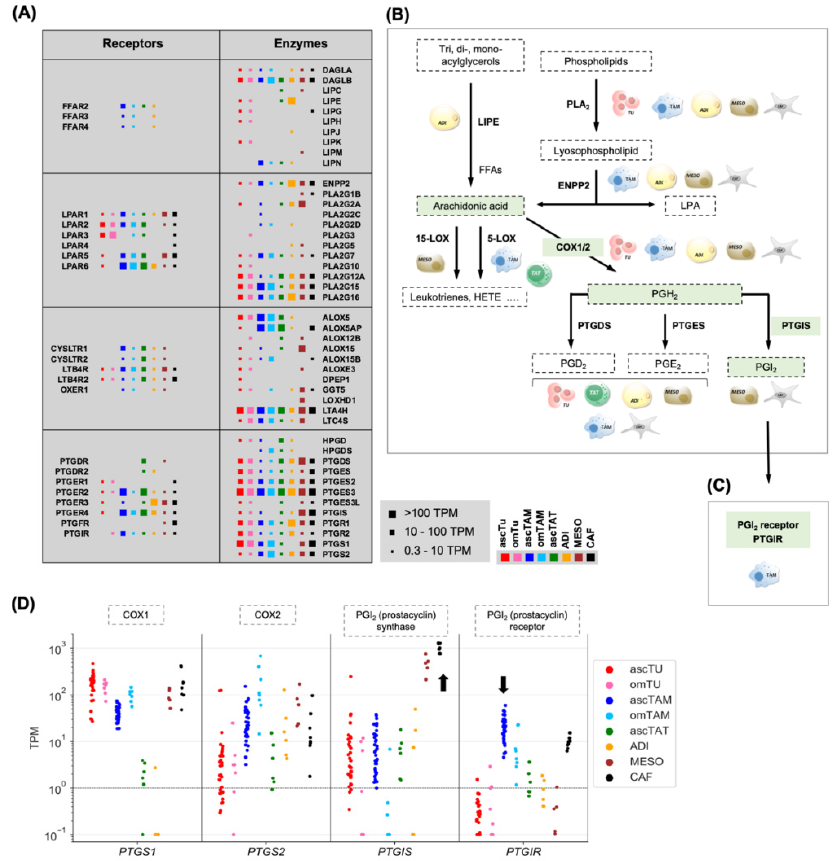
Figure 1. Cell-type-selective biosynthesis of lipid mediators and their targets in the omental TME. ( A ) Schematic representation of expression patterns of genes coding for key enzymes involved in lipid mediator synthesis or encoding lipid receptors in 8 different cell types as indicated (red: ascTU; pink: omTU; blue: ascTAM; cyan: omTAM; green: ascTAT; yellow: adipocytes;